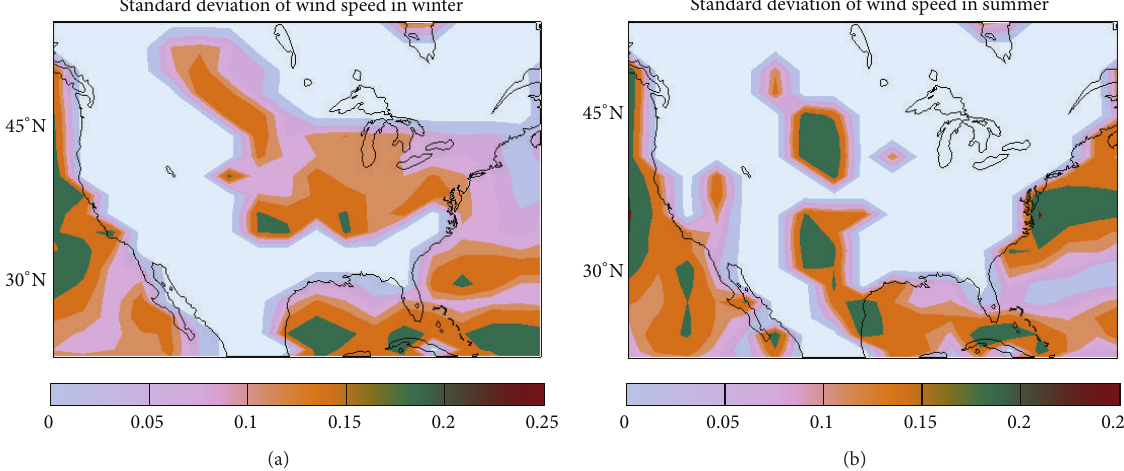
Figure 9: The intramodel standard deviation, with respect to the mean, as shown in Figure 8, of the percentage change in surface wind speed. (a) and (b) are for winter and summer, respectively. Where the standard deviation is not calculated (see text), it is set to zero and colored in gray. The color scale is shown at